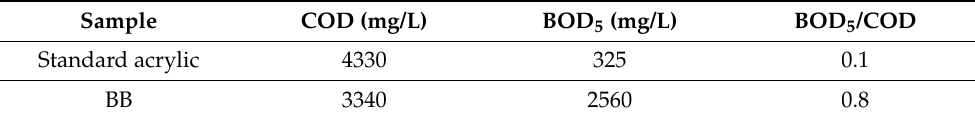
Table 5. COD, BOD 5 and biodegradability in residual